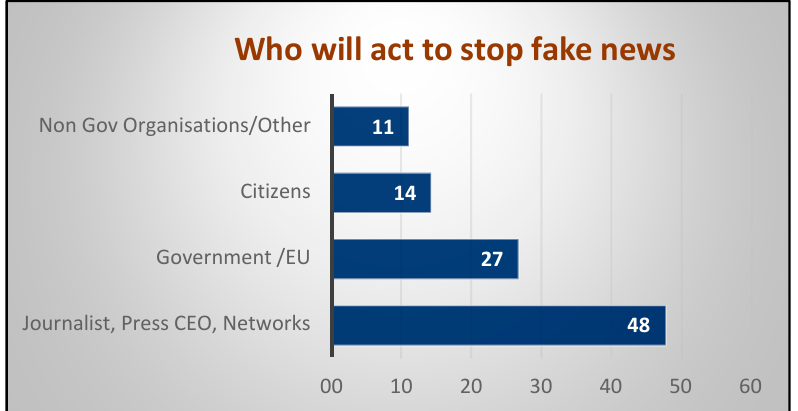
Figure 2. Who will stop fake news? (EU 2018). Source: Authors’ mathematical computation of data from Flash Eurobarometer 464 [14].